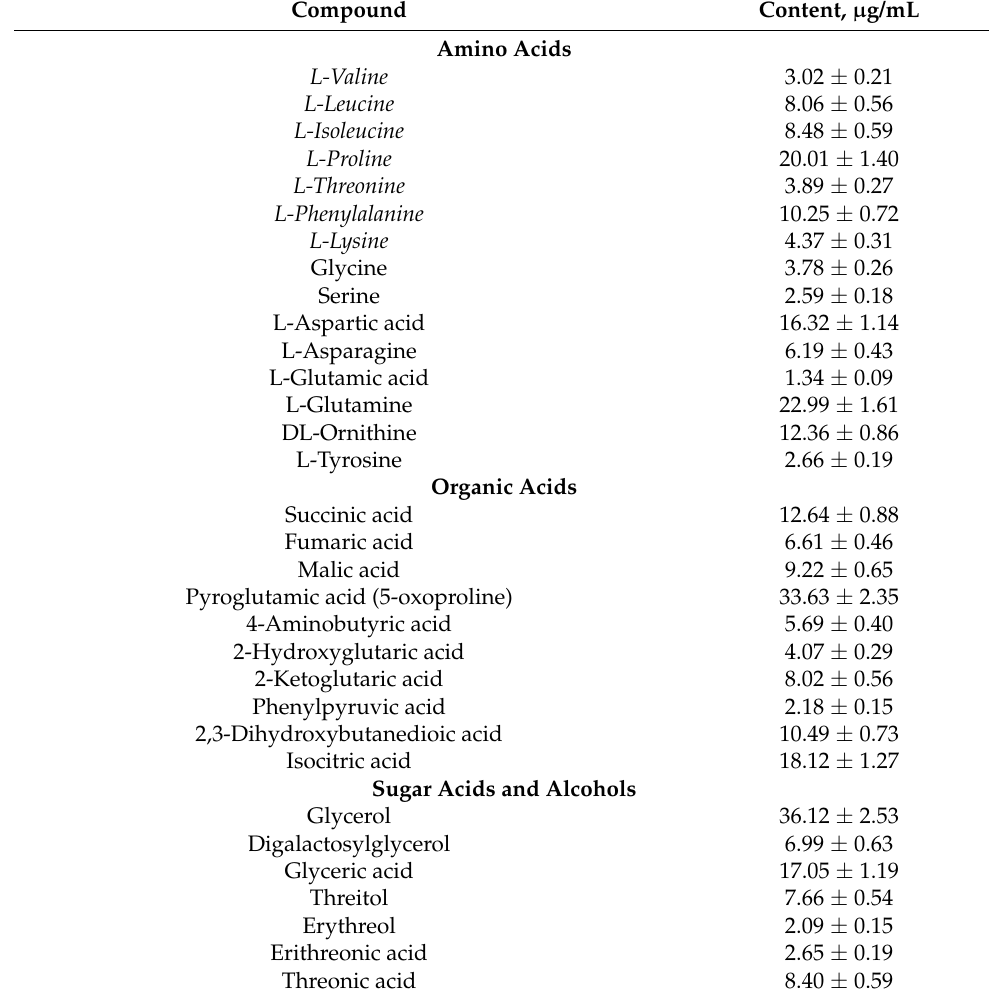
Table 1. List of polar phytochemicals identified in the analyzed polar fraction (A) of SE FAE using GC-MS technique. The concentration was given in µ g/mL extract. Results are presented as mean ± standard